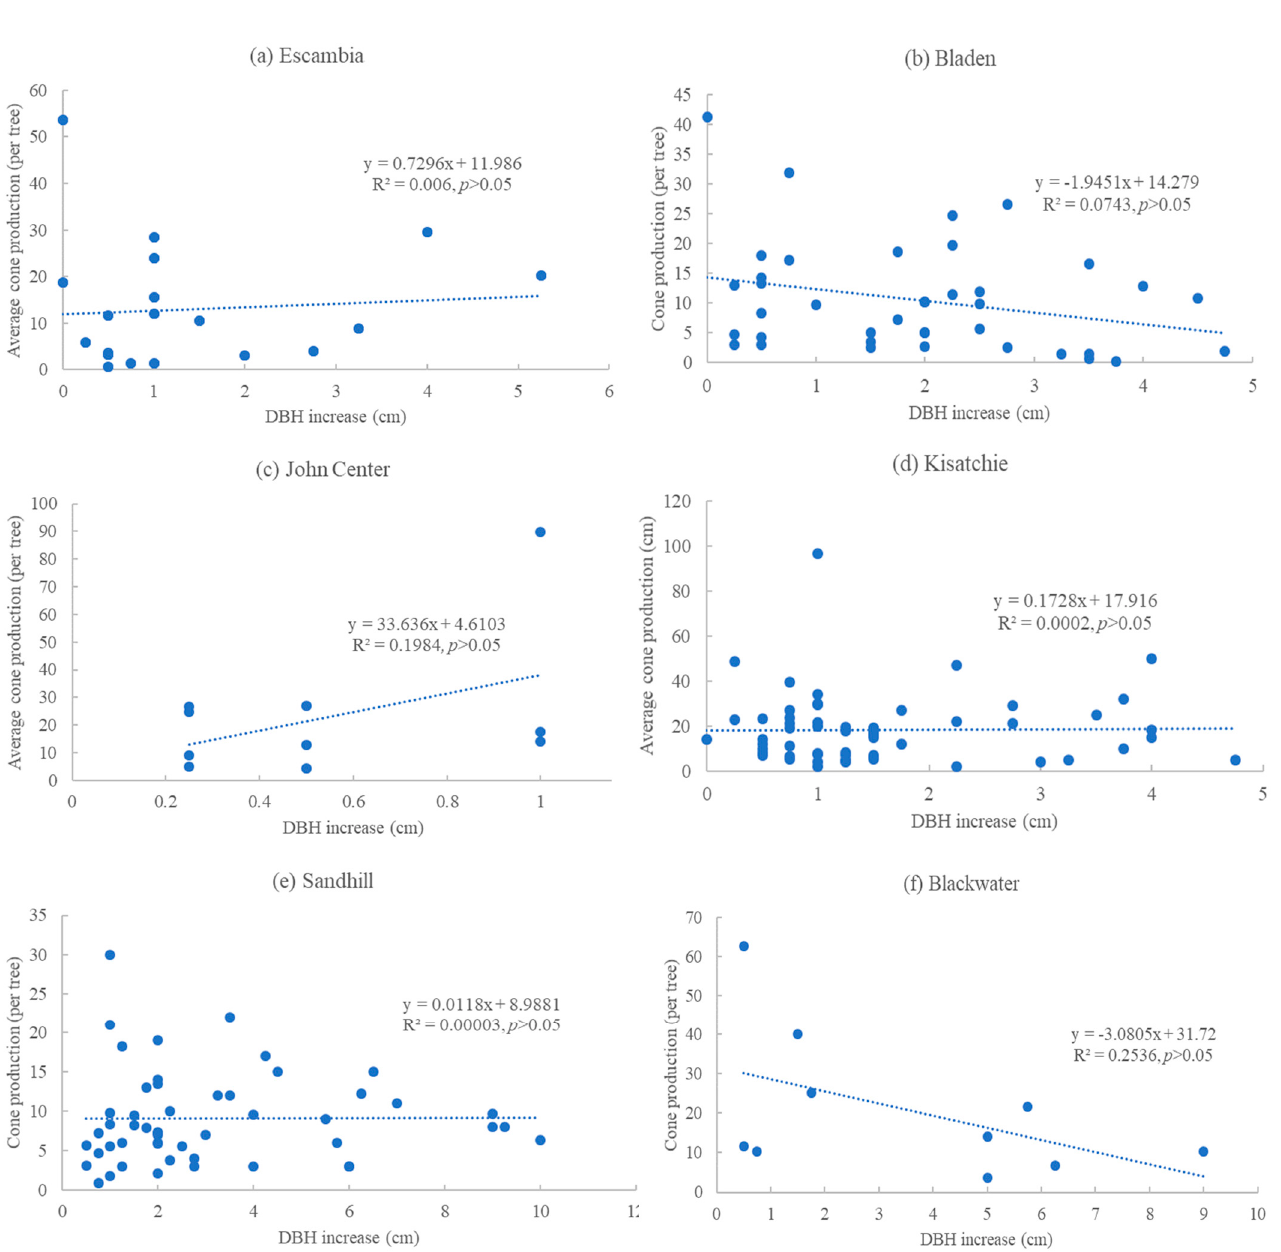
Figure 3. Relationships between diameter growth and the corresponding average cone production over time across sites.